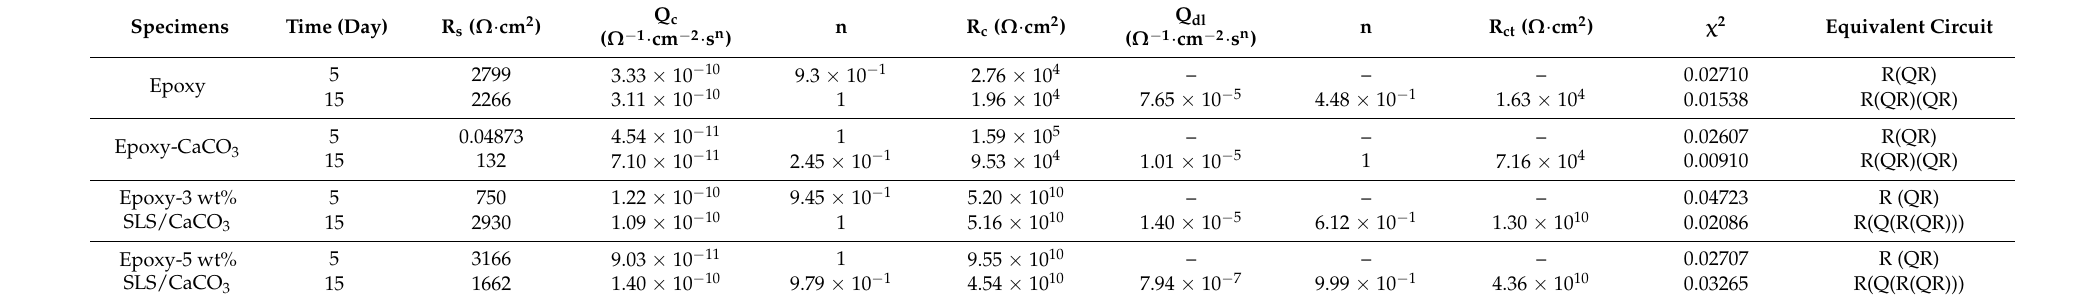
Table 2. Fitting electrochemical data of the applied coatings in the simulated concrete pore (SCP)